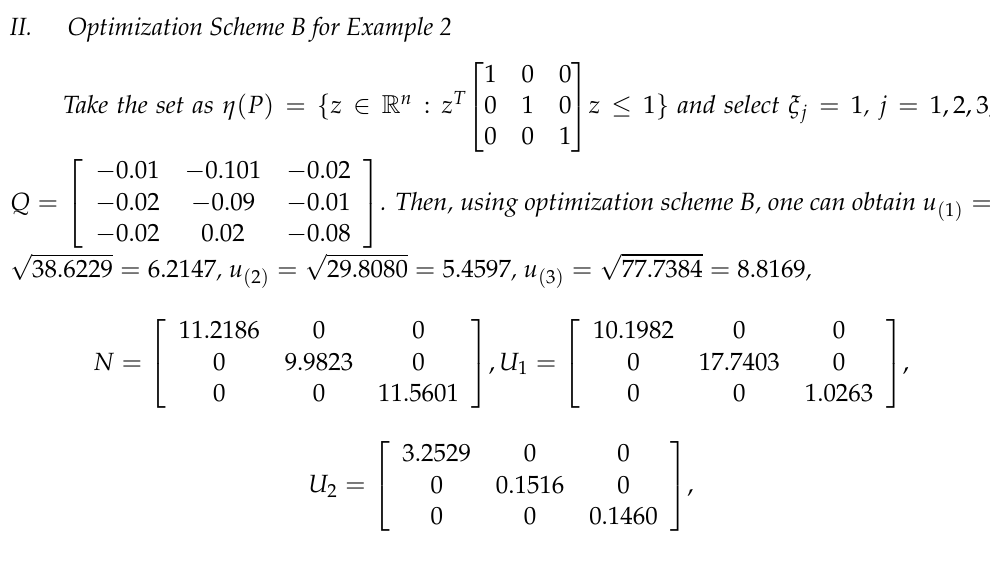
Figure 7. Trajectories of ( a ): z ( t ) ; ( b ): u ( t ) of Example 2 based on optimization scheme